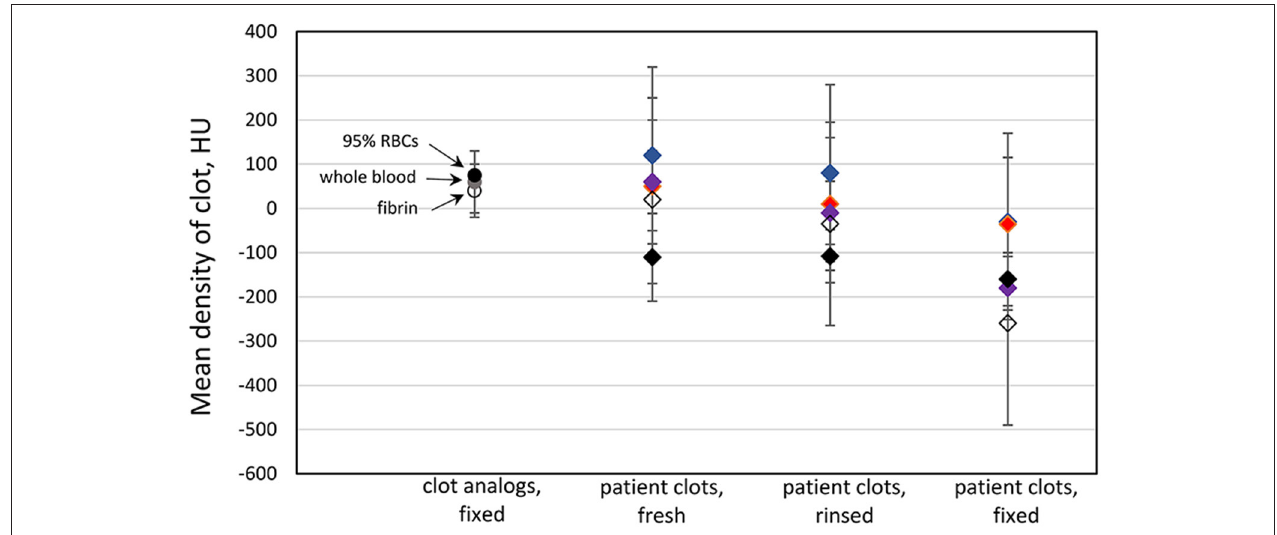
FIGURE 1 | Clot density in microCT—comparison of clot analogs and human clots at different processing stages. Data points represent the mean HU values for each clot, and the bars indicate the standard deviation of the density distribution within each clot. Same color of diamond shape data points was used for each individual clot. The clots were imaged in three states: fresh, rinsed in saline, and after being fixed in formalin.